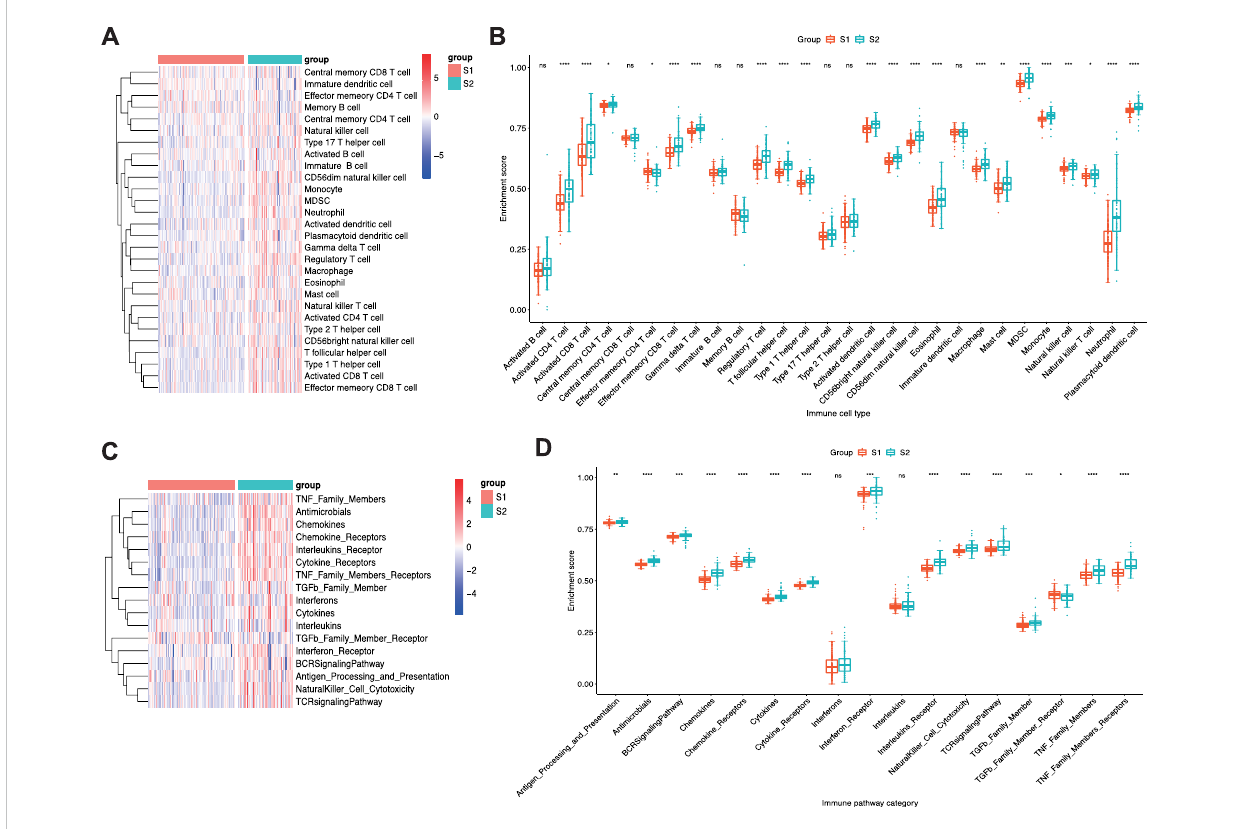
FIGURE 4 Immune landscape of senescence subtypes of IPF. (A) Heatmap and (B) boxplot of differential enrichment scores of immune cell signatures of two subtypes. (C) Heatmapand (D) boxplotofdifferentialenrichmentscoresofimmunepathwaycategoryoftwosubtypes.* p < 0.05,** p < 0.01,*** p < 0.001, **** p < 0.0001 and ns corresponds to no signi fi